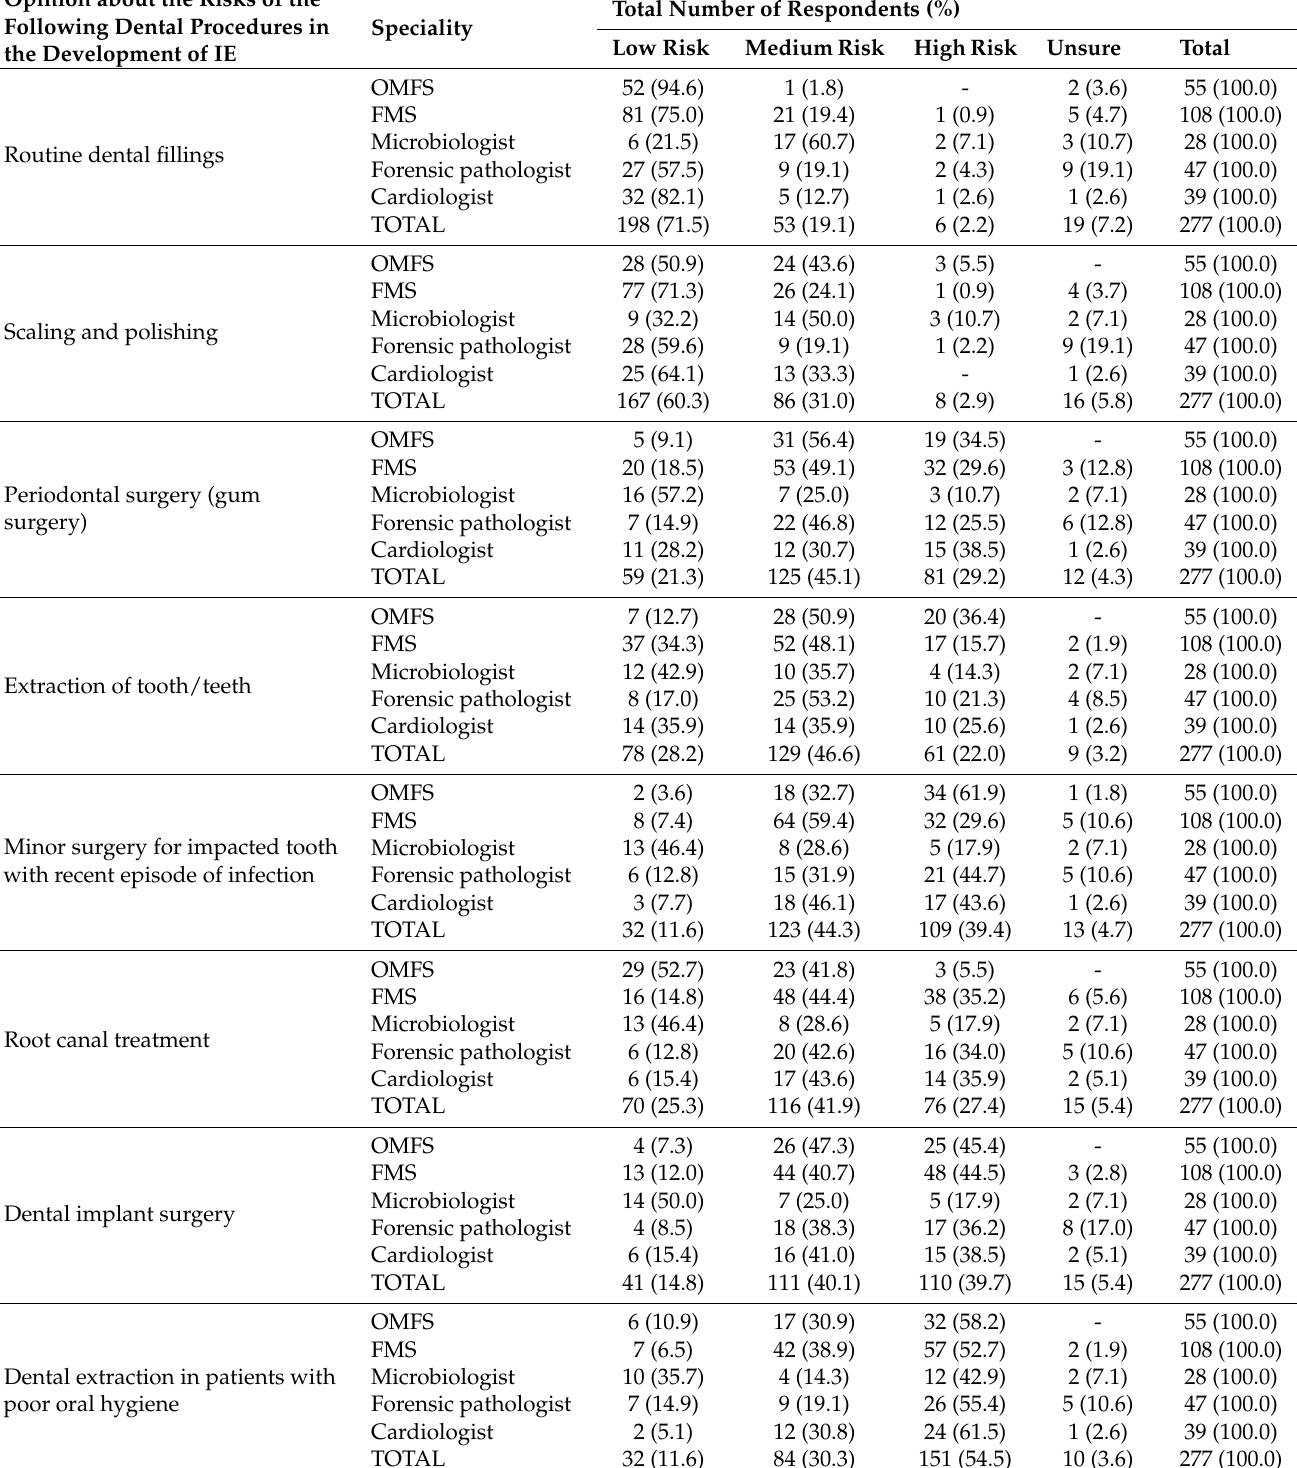
Table 5. The risk levels of infected endocarditis from selected dental procedures.